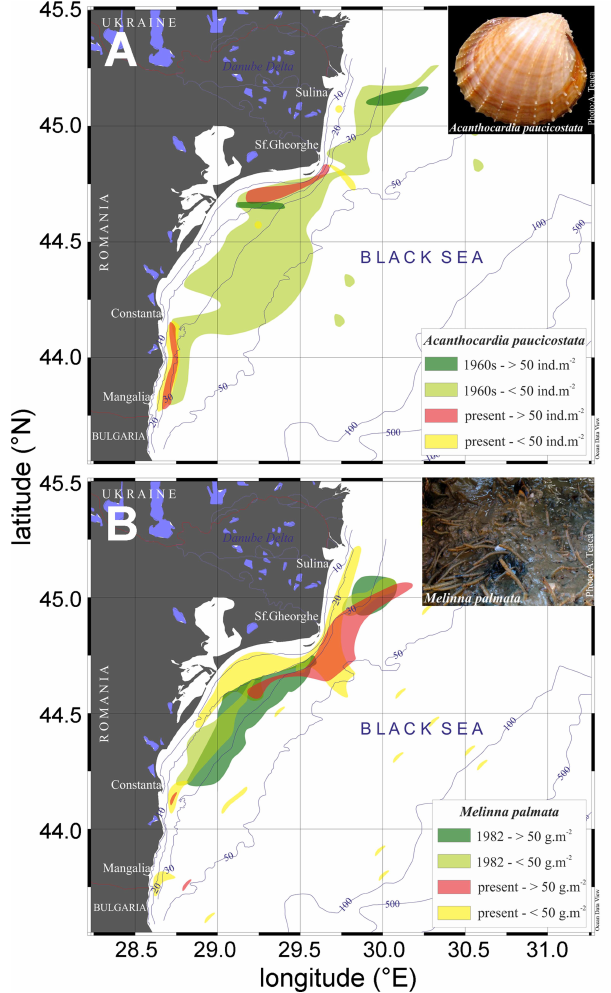
Fig. 21. The density distribution of the bivalve Acanthocardia pau- cicostata in the 1960s and after 2000 ( A ) and the biomass distribu- tion of the polychaete Melinna palmata in the 1980s and after 2000 ( B ) along the Romanian Black Sea coast. Bivalves are the losers and polychaetes are the winners in a situation of increasing eutrophica- tion and